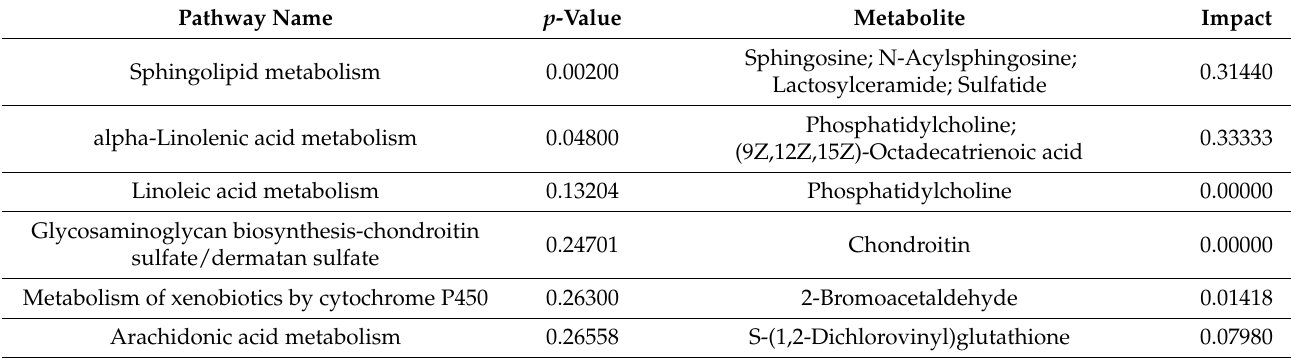
Table 3. The enriched KEGG pathway of differential metabolites of tMCAO/Sham in mouse